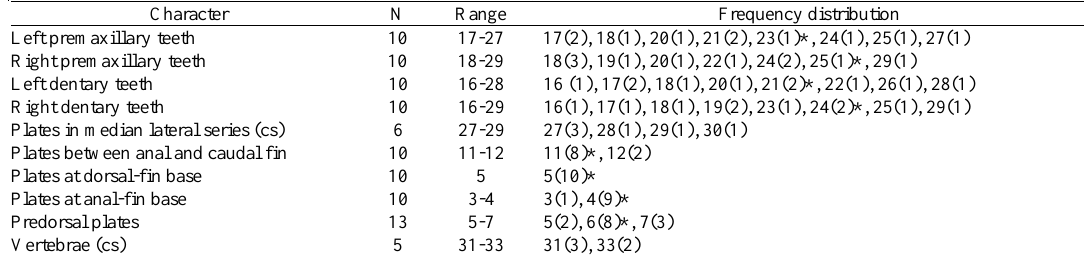
proximal radial. Supraneural without pair of processes along anterior margin. Spinelet reduced and plate-like, and dorsal- fin locking mechanism non functional. Adipose fin absent. Pectoral fin I,6, with posterior fin margin slightly rounded. Tip of depressed pectoral fin extending one-third of pelvic- fin length. Axillary slit of pectoral fin absent. Pelvic fin i,5, short, with robust thickened first ray. Tip of adpressed fin extending to point midway between anus and anal-fin origin in females. Reaching to or beyond anal-fin origin in males. Adult males with fleshy flap along posterodorsal margin of thickened first pelvic-fin ray. Anal fin i,5. Caudal fin i,14,i. Color in alcohol. Ground color of dorsal surface of head and body light to median brown; pale yellowish, mostly unpigmented ventrally. Longitudinal dark brown stripe present on lateral surface of head and body. Stripe begins laterally on snout tip and extends to end of caudal peduncle. Four inconspicuous darker saddles on dorsal surface of body. First Table 2. Frequency of distribution of meristic data for Microlepidogaster longicolla . Holotype values are marked with an asterisk. cs = Counted in c&s specimens. N= number of